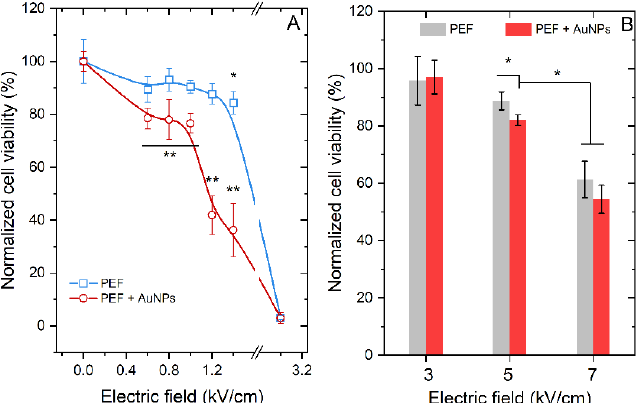
Figure 9. Viability of cells following electrotransfection with and without AuNPs, where ( A ) ESOPE protocols; ( B ) MHz burst of nanosecond pulses. Asterisk (*) corresponds to statistically significant difference ( p < 0.05) versus untreated control, unless marked differently. Asterisk (**) corresponds to statistically significant difference ( p < 0.05) versus PEF only treatment.